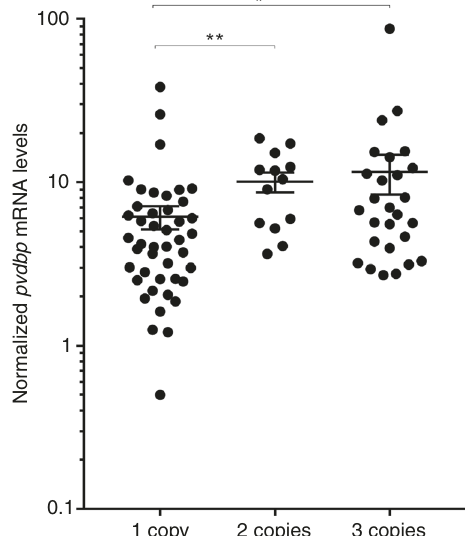
Fig. 1 Increased PvDBP gene copy number leads to increased mRNA levels in mature Pv schizonts. PvDBP mRNAs were normalized against the schizont-speci fi c PvMSP1 gene. mRNA level is on average higher in parasites with two ( n = 13) and three ( n = 27) copies of pvdbp compared to single copy ( n = 44) ones (Kruskal-Wallis H = 12.39, P = 0.020, Dunn ’ s post-hoc tests, * P < 0.05, ** P < 0.001). Each dot represents the pvdbp mRNA quanti fi cation of a different clinical isolate. Mean± SEM. Source data are provided as a Source Data fi